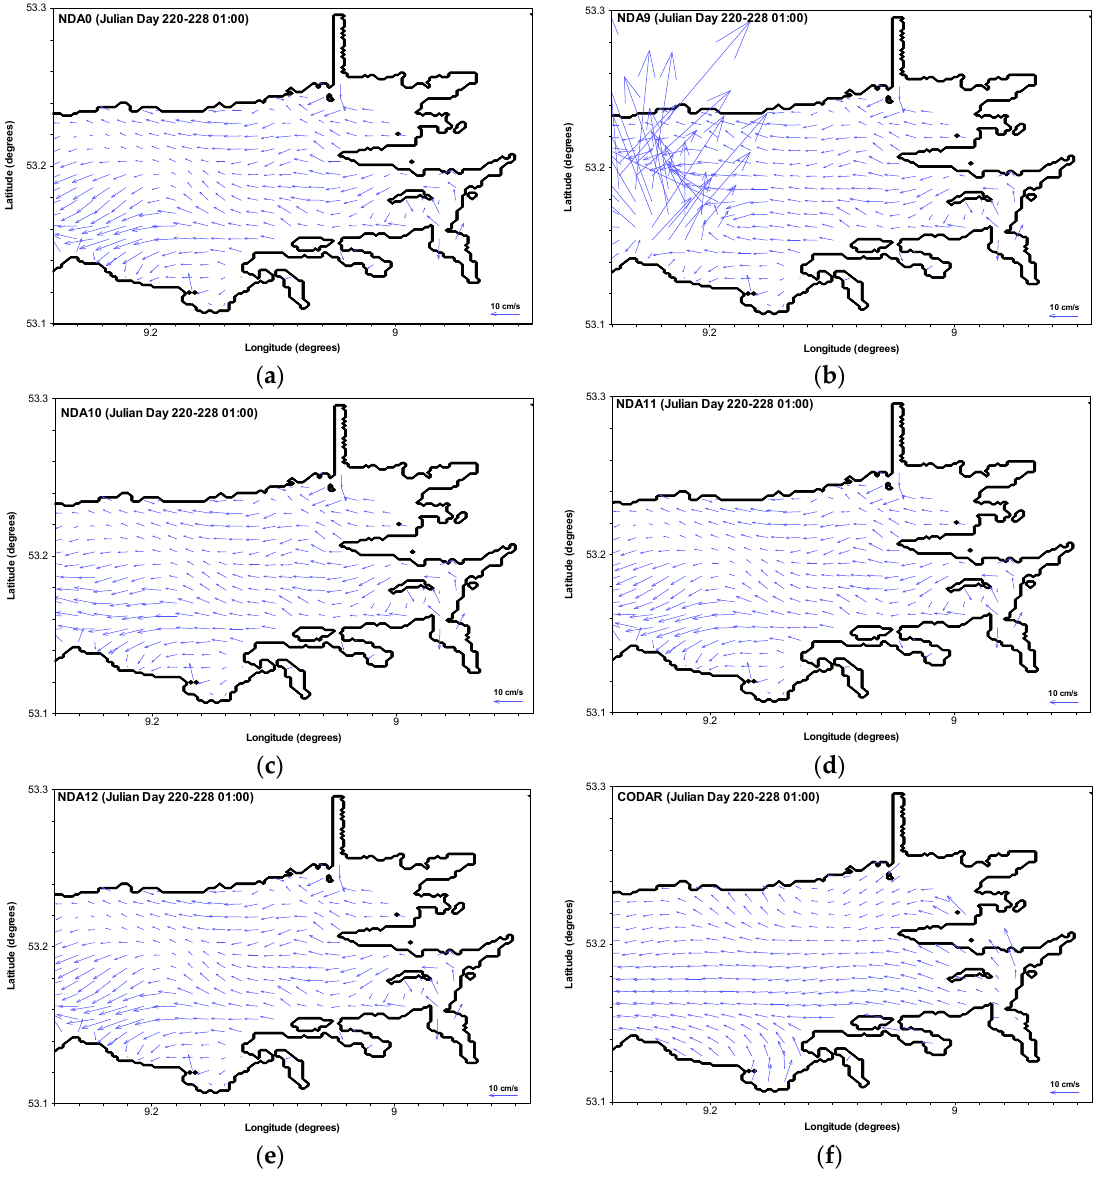
Figure 5. Mean surface flow fields during Julian Day 220–228 01:00 (( a ) is averaged flow field from model NDA0, ( b – e ) are averaged flow fields from model NDA9-NDA12, respectively; ( f ) is averaged flow field of radar data).